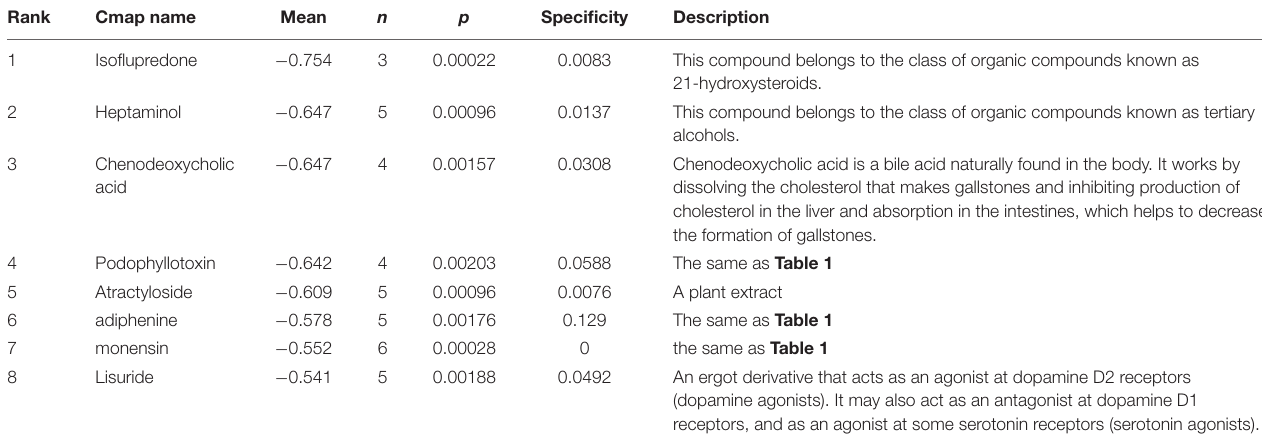
TABLE 2 | Top small molecules based on the genes co-expressed with